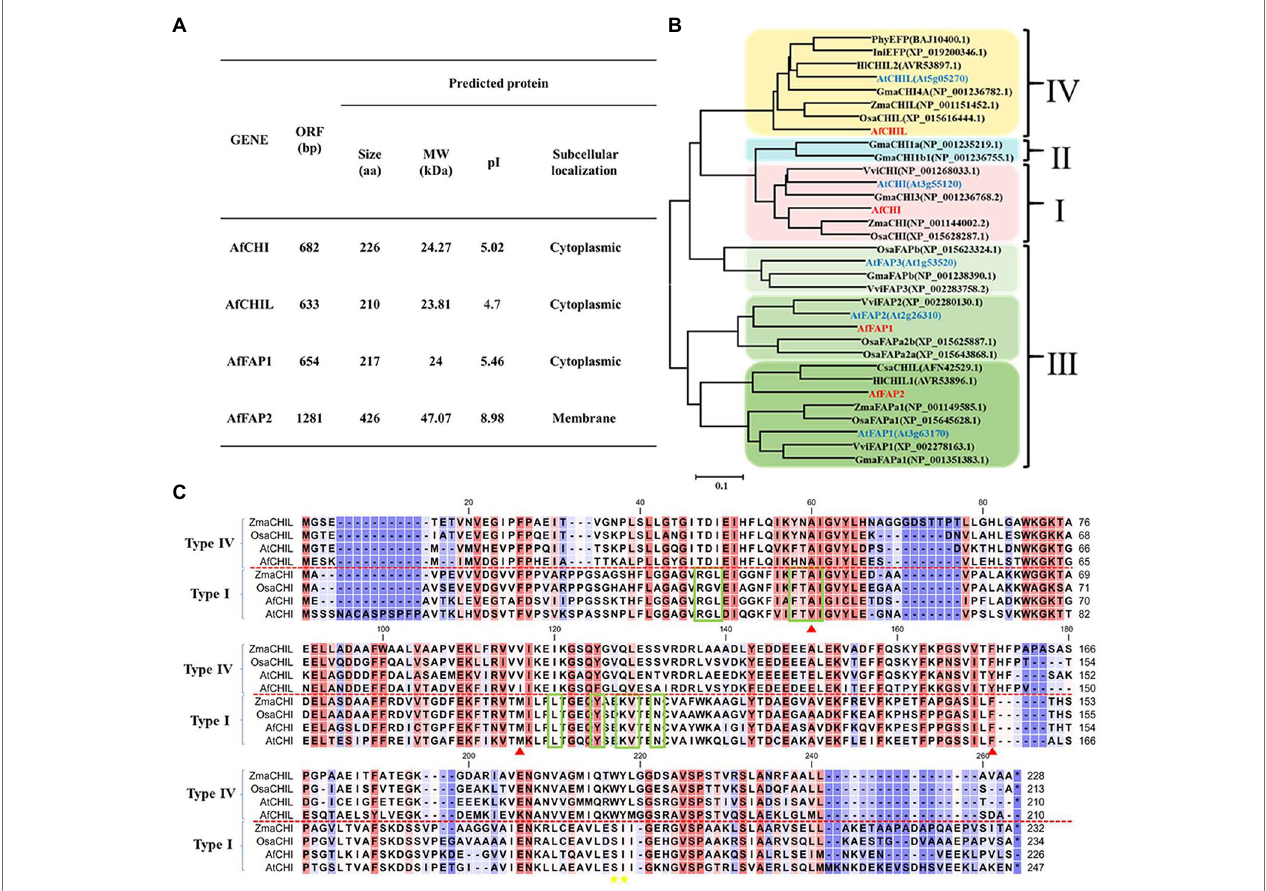
FIGURE 2 | Molecular characteristics of AfCHIs proteins in Allium fistulosum . (A) Information of chalcone isomerase genes in A. fistulosum . (B) Phylogenetic analysis of AfCHIs proteins from A. fistulosum and other plants. The tree was constructed by MEGA6 based on the multiple sequence alignment conducted by ClustalW and using the Neighbor-joining method. (C) Sequence alignment of A. fistulosum type I and type IV CHIs with others from Arabidopsis thaliana , Oryza sativa , and Zea mays . The green box represented the key residues of ( 2S )-naringenin binding cleft, respectively. Red triangles indicated the hydrogen bond network in the active